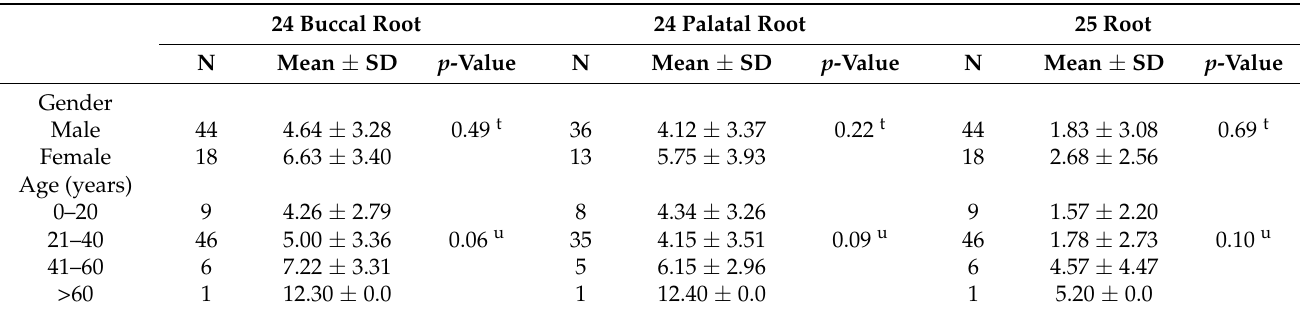
Table 4. Measurements of distances (mm) between apices of left premolar roots and floor of the maxillary sinus concerning age and gender ( n = 62).